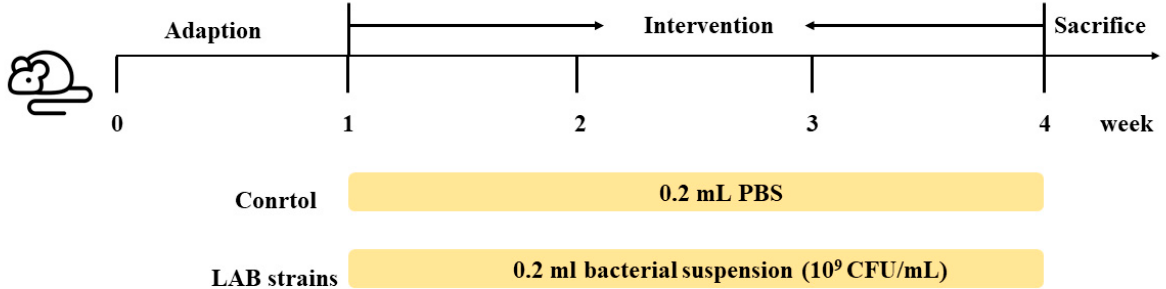
Figure 1. Schematic of the animal experiment. Five strains were included in the lactic acid bacteria (LAB) groups, Lactobacillus strains X6L1, S24-1, 12-1, 24M1 and